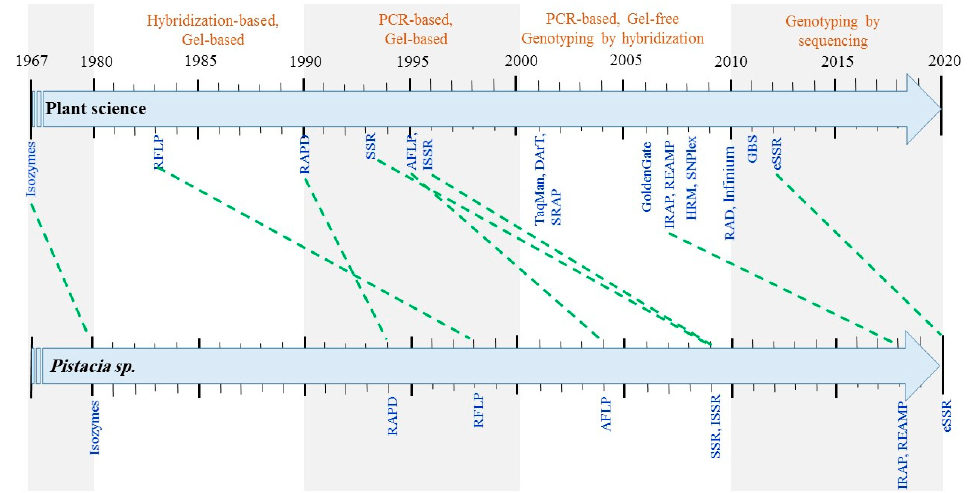
Figure 1. Timeline for the first scientific report for the employment of different commonly used markers in plant science and genus Pistacia from isoenzymes to modern molecular makers such as RFLP, RAPD, AFLP, SSR, ISSR, IRAP, REAP and GBS (for detail description see text below).